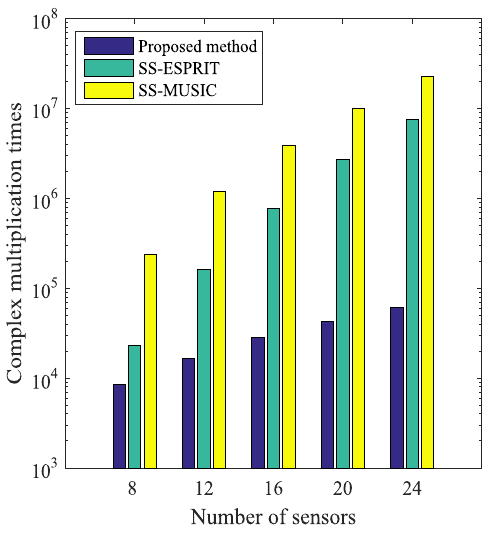
Figure 2. Comparison of complexity versus number of sensors.